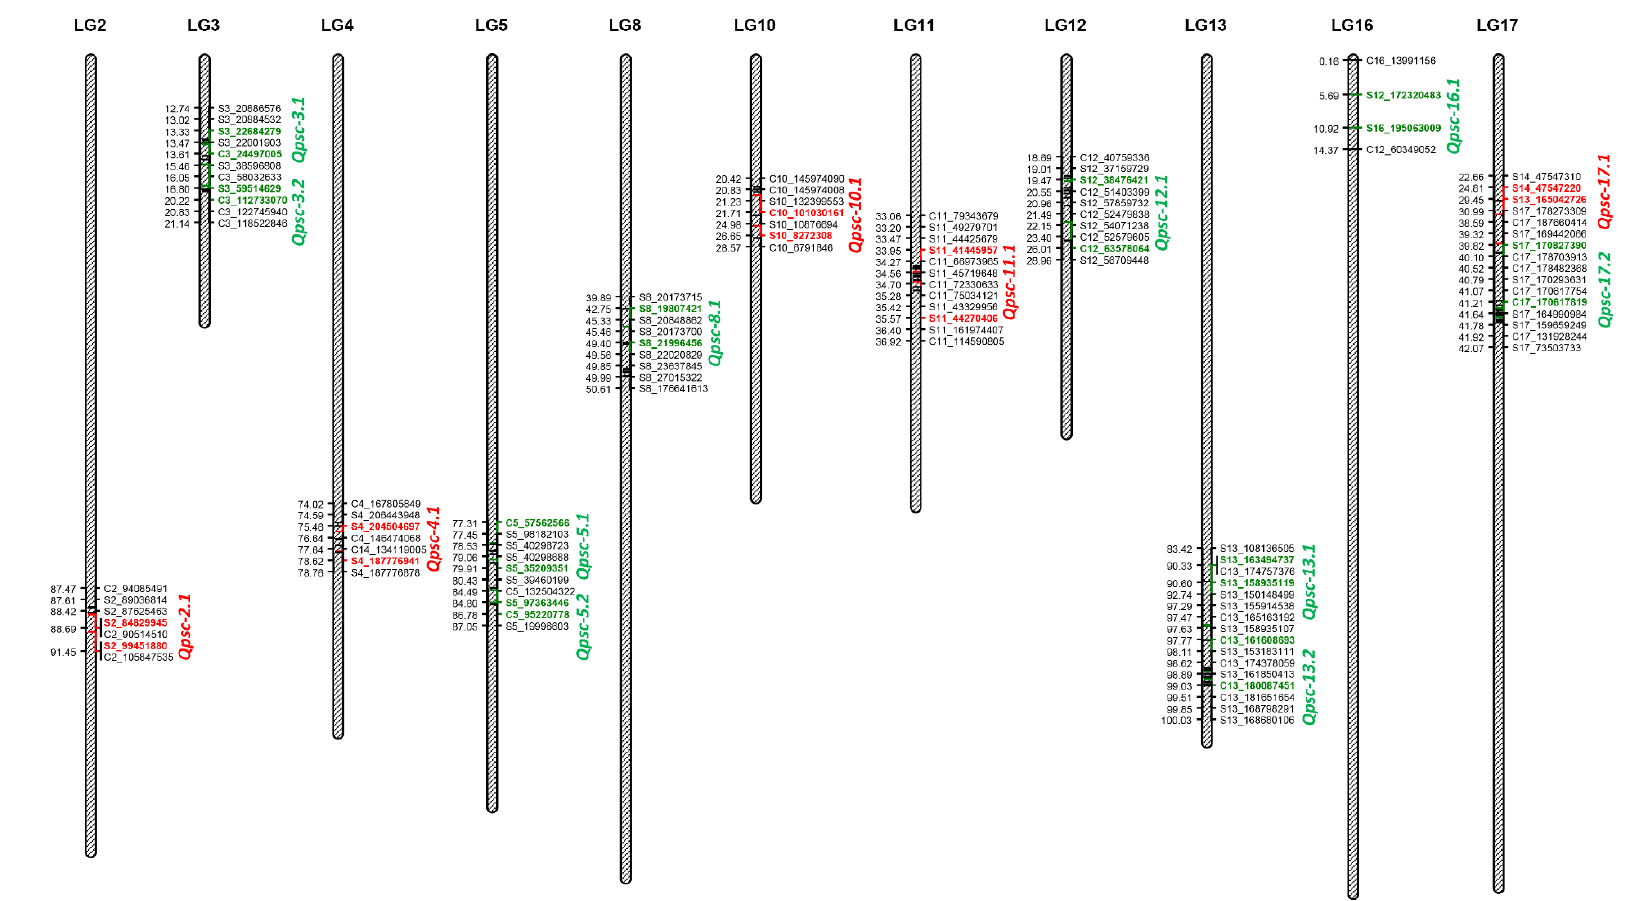
Figure 2. Quantitative trait loci (QTL) associated with Phomopsis stem canker (PSC) resistance identified in the HA 89 / HA-R3 recombinant inbred line population tested in multiple environments during 2016 to 2018. The alleles for increased PSC resistance contributed by the HA-R3 parent are indicated in green, while the resistance alleles contributed by the HA 89 parent are indicated in red. The colored SNPs indicate the markers flanking PSC resistance QTL.